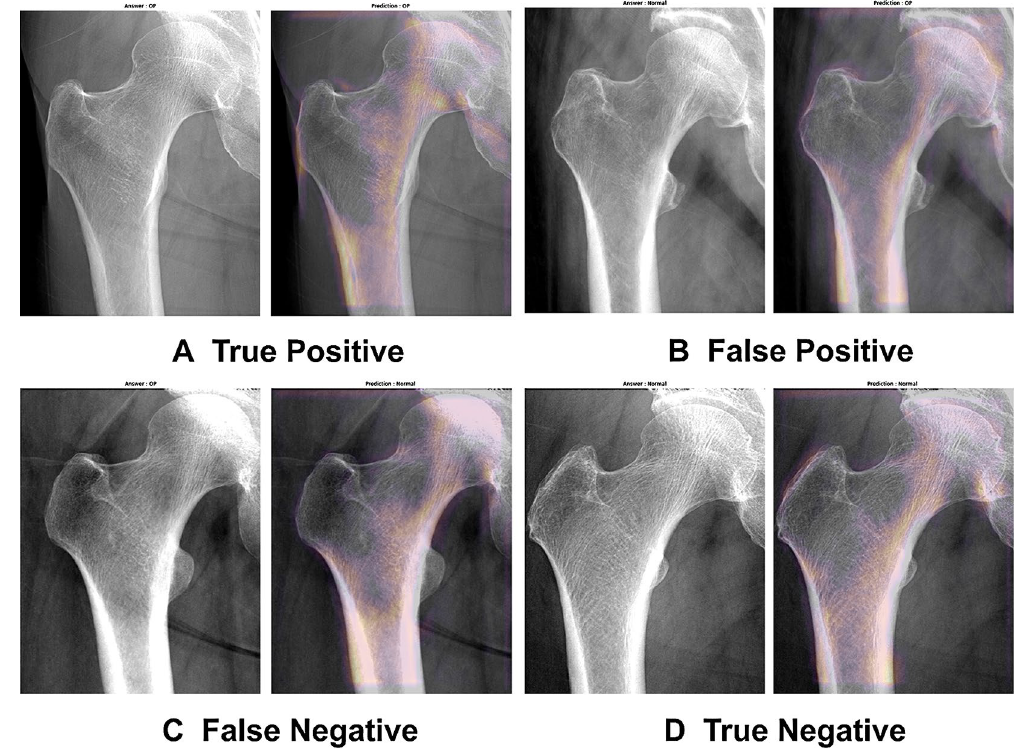
Figure 2. Visualization of the region of interest that our final neural network model interpreted based on Grad- CAM results. The comparison of cropped X-ray images (left) and Grad-CAM result that overlapped on original images (right). The case of true positive that predicted osteoporosis in a patient with real osteoporosis is shown in ( A ), false positive in ( B ), false negative in ( C ), and true negative in ( D ).